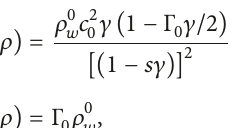
Figure 8: Mesh partition of the fluid